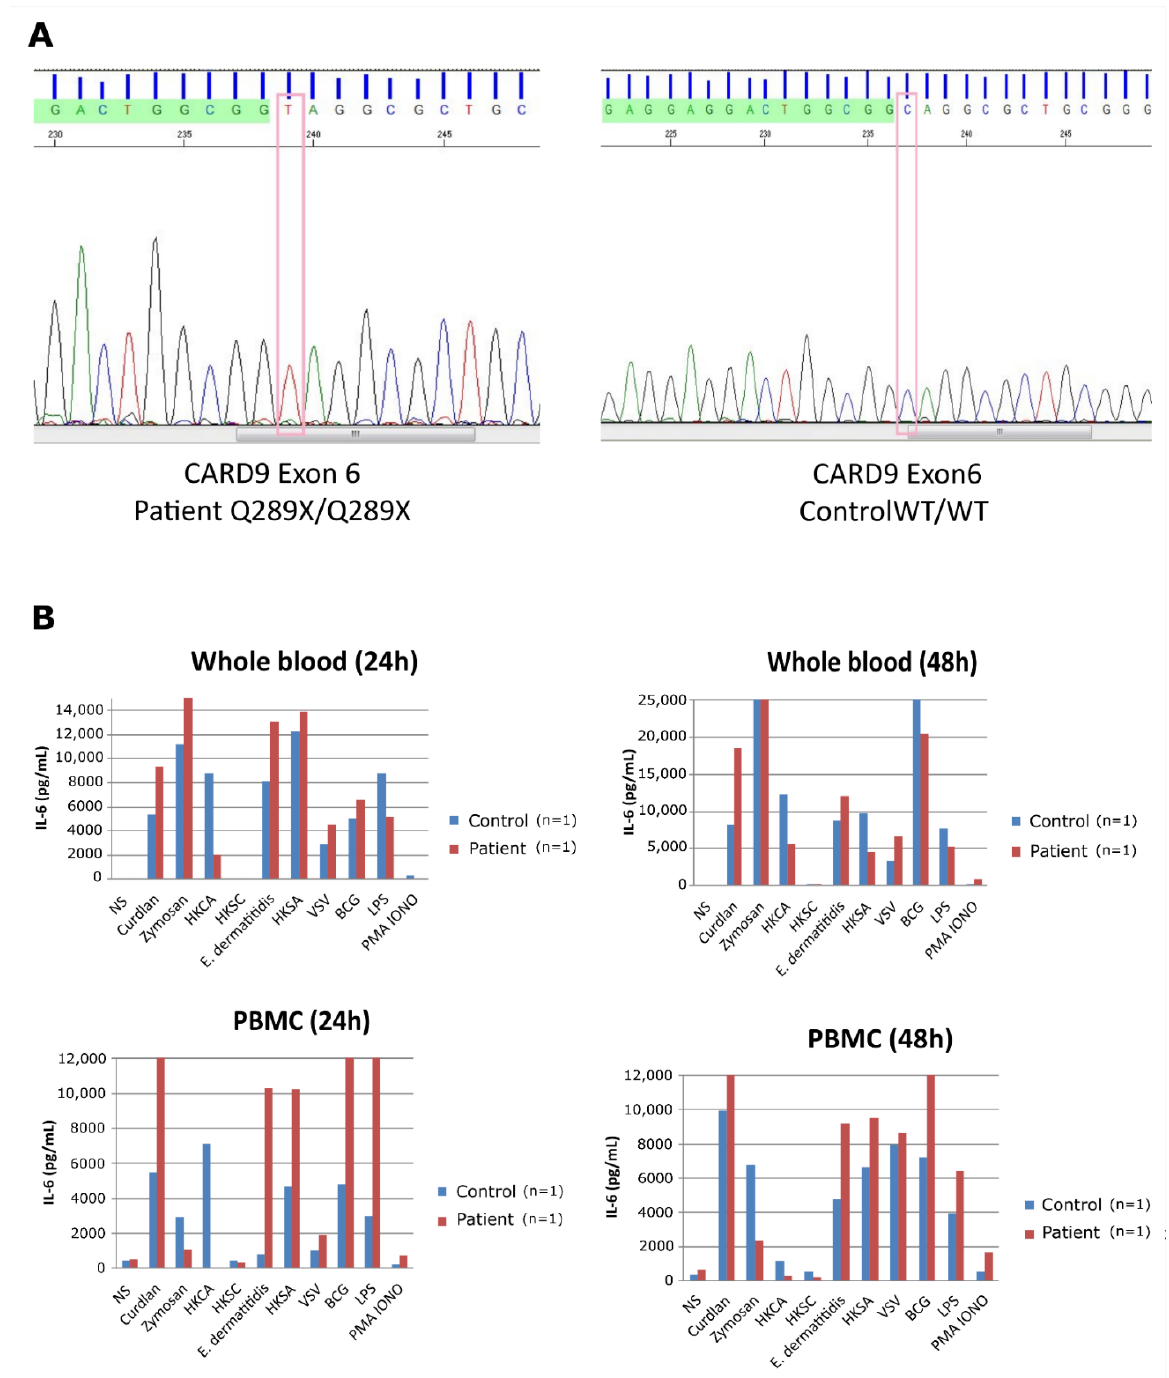
Figure 3. Patient whole blood ( A ) and peripheral blood mononuclear cells ( B ) were stimulated, and interleukin-6 (IL-6) production was measured in the supernatant after 24 and 48 h. Note the subject’s reduced IL-6 production after stimulation with heat-killed Candida albicans (HKCA) compared to control. Note. BCG, Bacille Calmette Guérin; LPS, lipopolysaccharide; HKCA, heat-killed Candida albicans , HKSC, heat-killed Saccharomyces cerevisiae ; HKSA, heat-killed Staphylococcus aureus ; NS, non-stimulated; PMA iono, PMA/ionomycin; VSV, vesicular stomatitis virus.